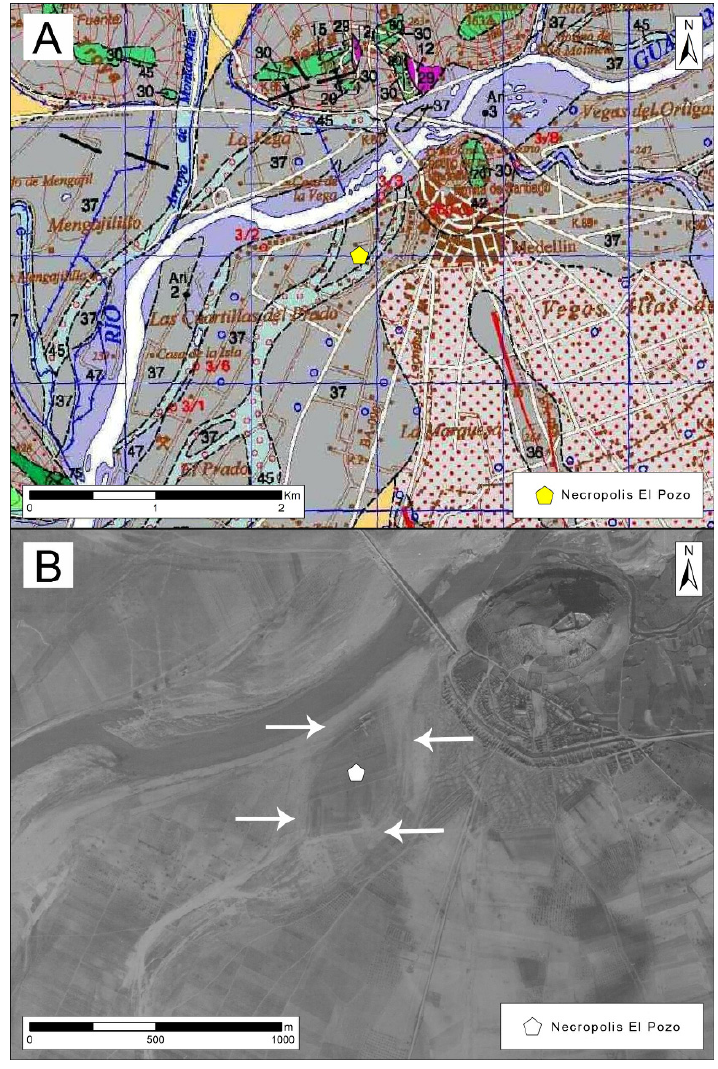
Figure 11. ( A ) National geological map (IGME, sheet 778) showing the location of the necropolis of El Pozo. It shows the presence of a branch of the Guadiana running to the south of the necropolis, which no longer exists. ( B ) Photograph of American Flight A (1945/1946) showing the location of the necropolis of El Pozo. The white arrows show the traces of the paleochannels of the Guadiana, which have now dried up.